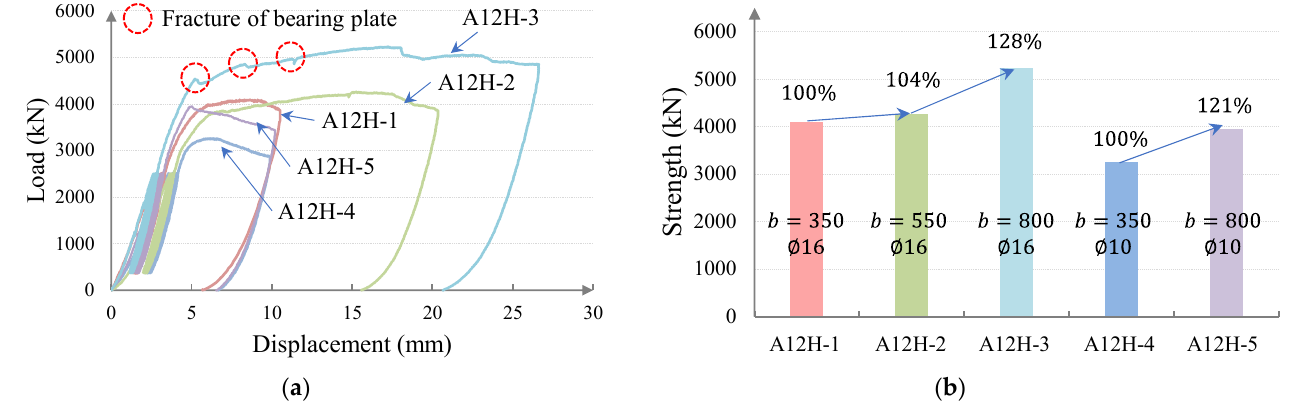
Figure 7. Group 1 test results ( 𝐷 = 295 mm ): ( a ) load-displacement curve; ( b ) ultimate bearing strength.